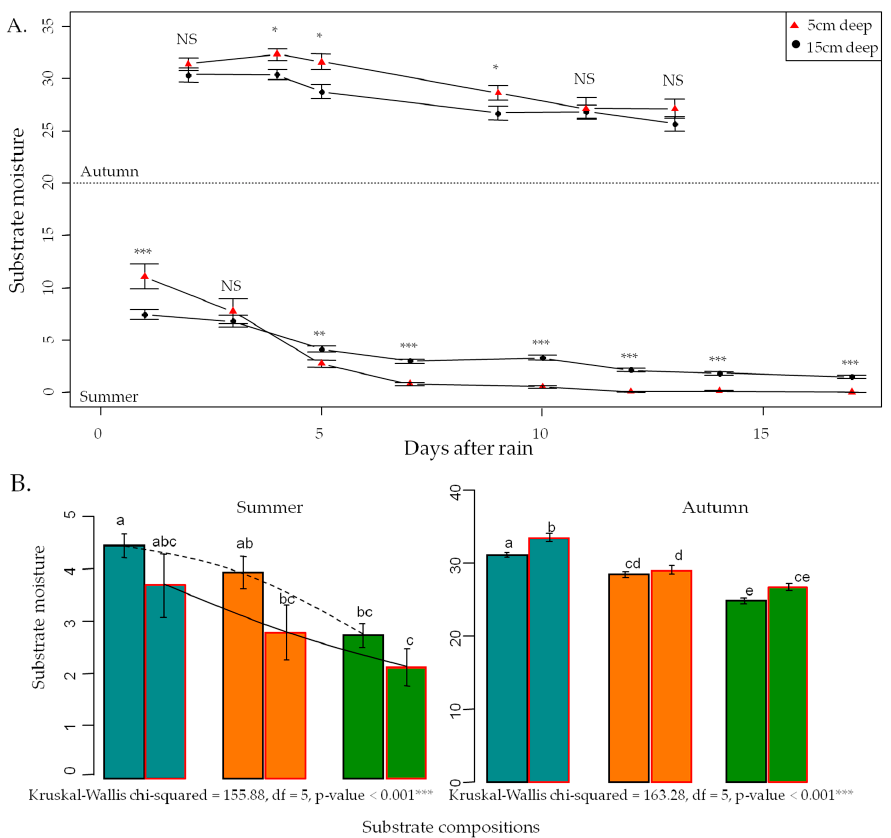
Figure 4. Interaction plot for soil moisture (from GLS and GLM) between ( A ) substrate depth and number of days after rain in summer and autumn 2016 (means and standard errors) and ( B ) Substrate composition with substrate depth, on the roof of Avignon IUT (Southeastern France) in summer and autumn 2016. Mixtures are indicated by the color background (blue: 25% pebble-sand and 75% clay-silt; orange: 50% pebble-sand and 50% clay-silt; green: 75% pebble-sand and 25% clay-silt) and the substrate thicknesses by the color of the quadrats framing (red: 5 cm, black: 15 cm). Values are means of substrate moisture ± standard errors for each substrate thickness and for each survey period. The stars represent significant differences between the two thicknesses for a survey date, NS: not significant from the post hoc test of Mann-Whitney-Wilcoxon test. Two values in the same row with a different letter are significantly different according to Mann-Whitney-Wilcoxon test [52].